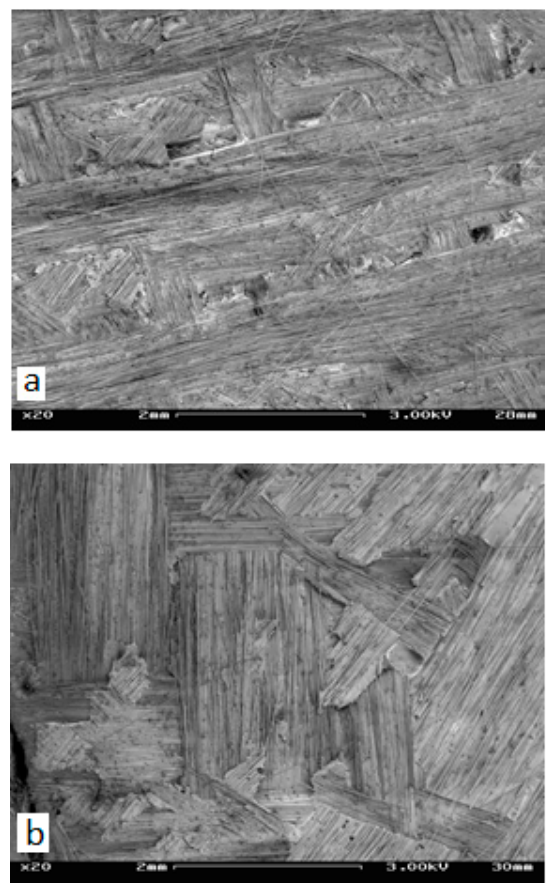
Figure 17. The complex morphology of the delamination surface: ( a ) Laminate A and ( b ) Laminate B.